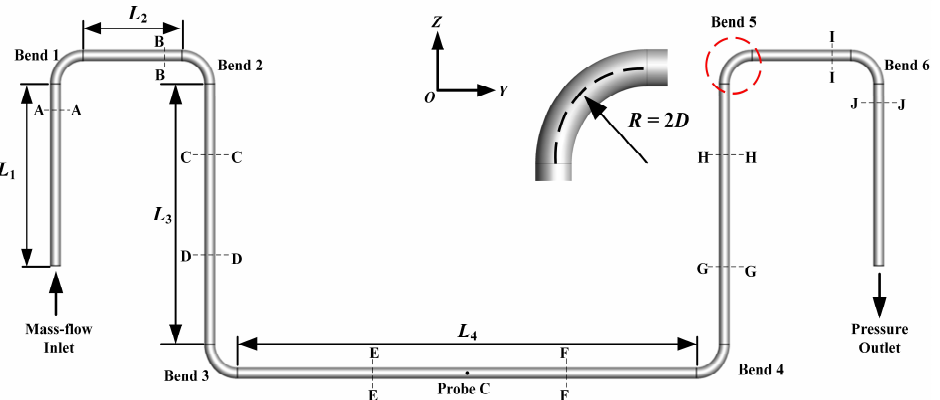
Figure 1. Schematic of the M-shaped jumper with definition of geometric parameters and the locations of monitored cross-sections and probe, where Z and Y are two coordinate axes, L 1 denotes the length of inlet upward tube, L 2 denotes the length of the top short horizontal tube, L 3 is the length of each inside vertical tube, L 4 is the length of the bottom long horizontal tube, R is the curvature radius of bends, D is the jumper external diameter, A-A, B-B, C-C, D-D, E-E, F-F, G-G, H-H, I-I and J-J denote the selected cross-sections along the